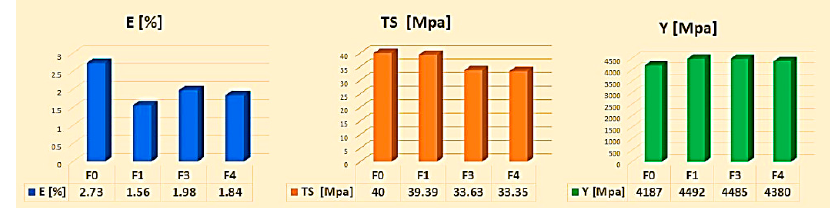
Figure 1. Mechanical properties of PLA/PHB matrix and PLA/PHB/NC